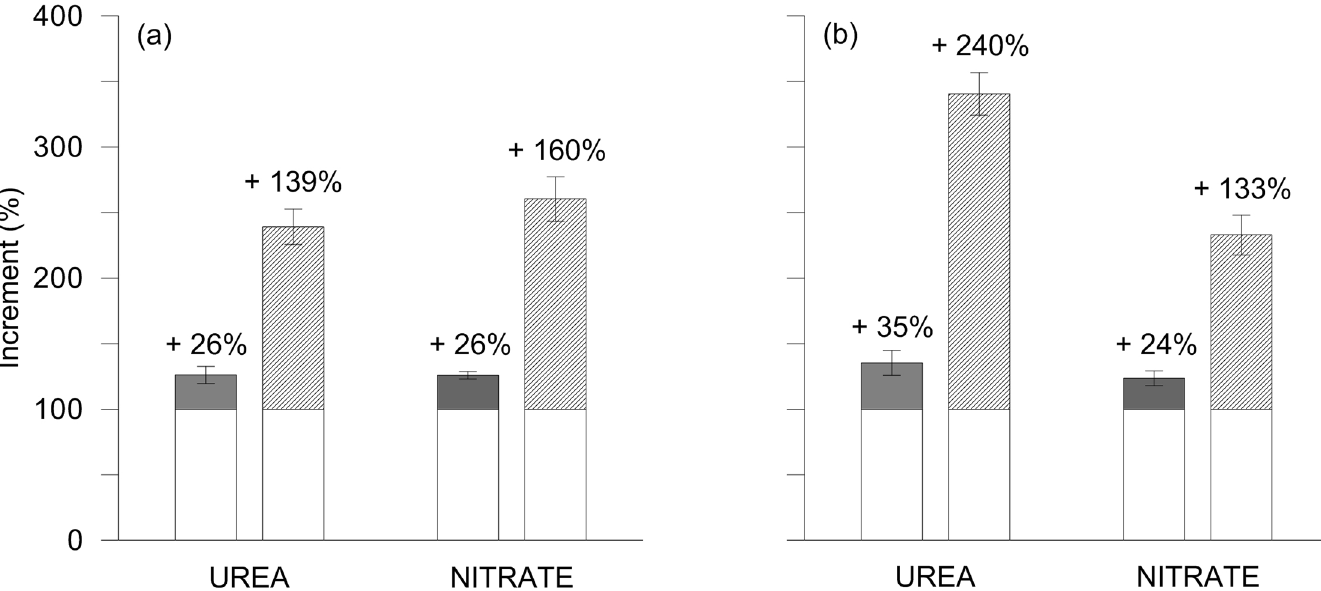
Fig 3. Increment of gliadins and glutenins in durum wheat mature grains under UREA and NITRATE fertilisation treatments respect to CONTROL. Percentage increments of gliadins (grey chart) and glutenins (diagonal lines; LMW-GS plus HMW-GS fractions) with respect to CONTROL (white chart) in durum wheat fertilized with urea (UREA) and calcium nitrate (NITRATE) at the rate of 150 kg N ha -1 in 2011 (a) and 2012 (b). Data are averages ± standard errors, for n = 3 independent